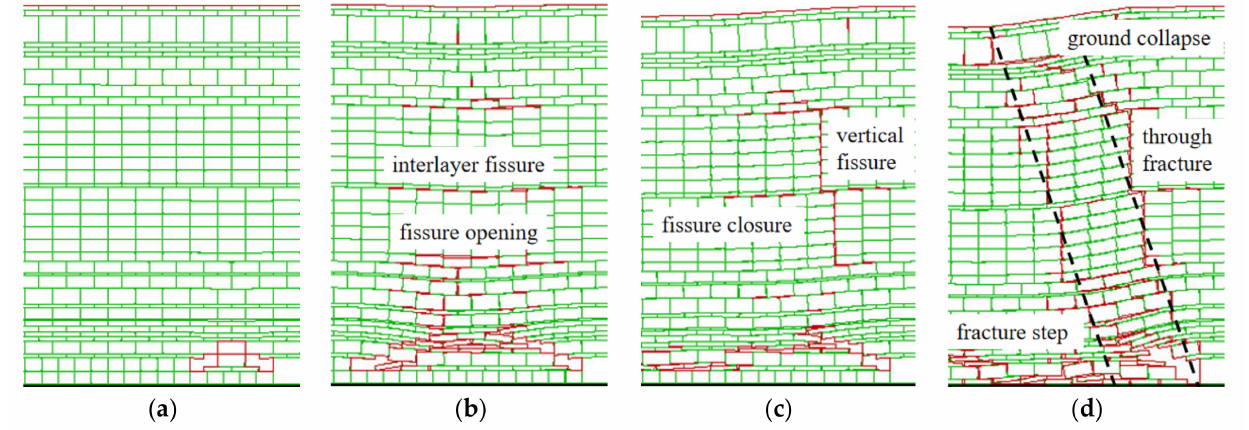
Figure 12. Failure characteristics of overburden under the mining of a super thick coal seam, obtained by numerical simulation: ( a ) initial collapse; ( b ) periodic caving with fissure opening; ( c ) periodic caving with fissure closure; ( d ) fracture distribution after the caving